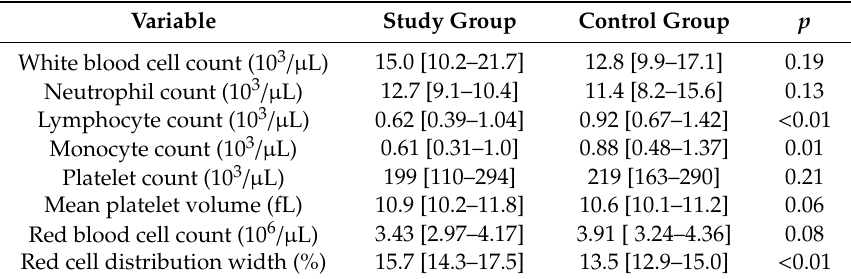
Table 2. Selected parameters of whole blood